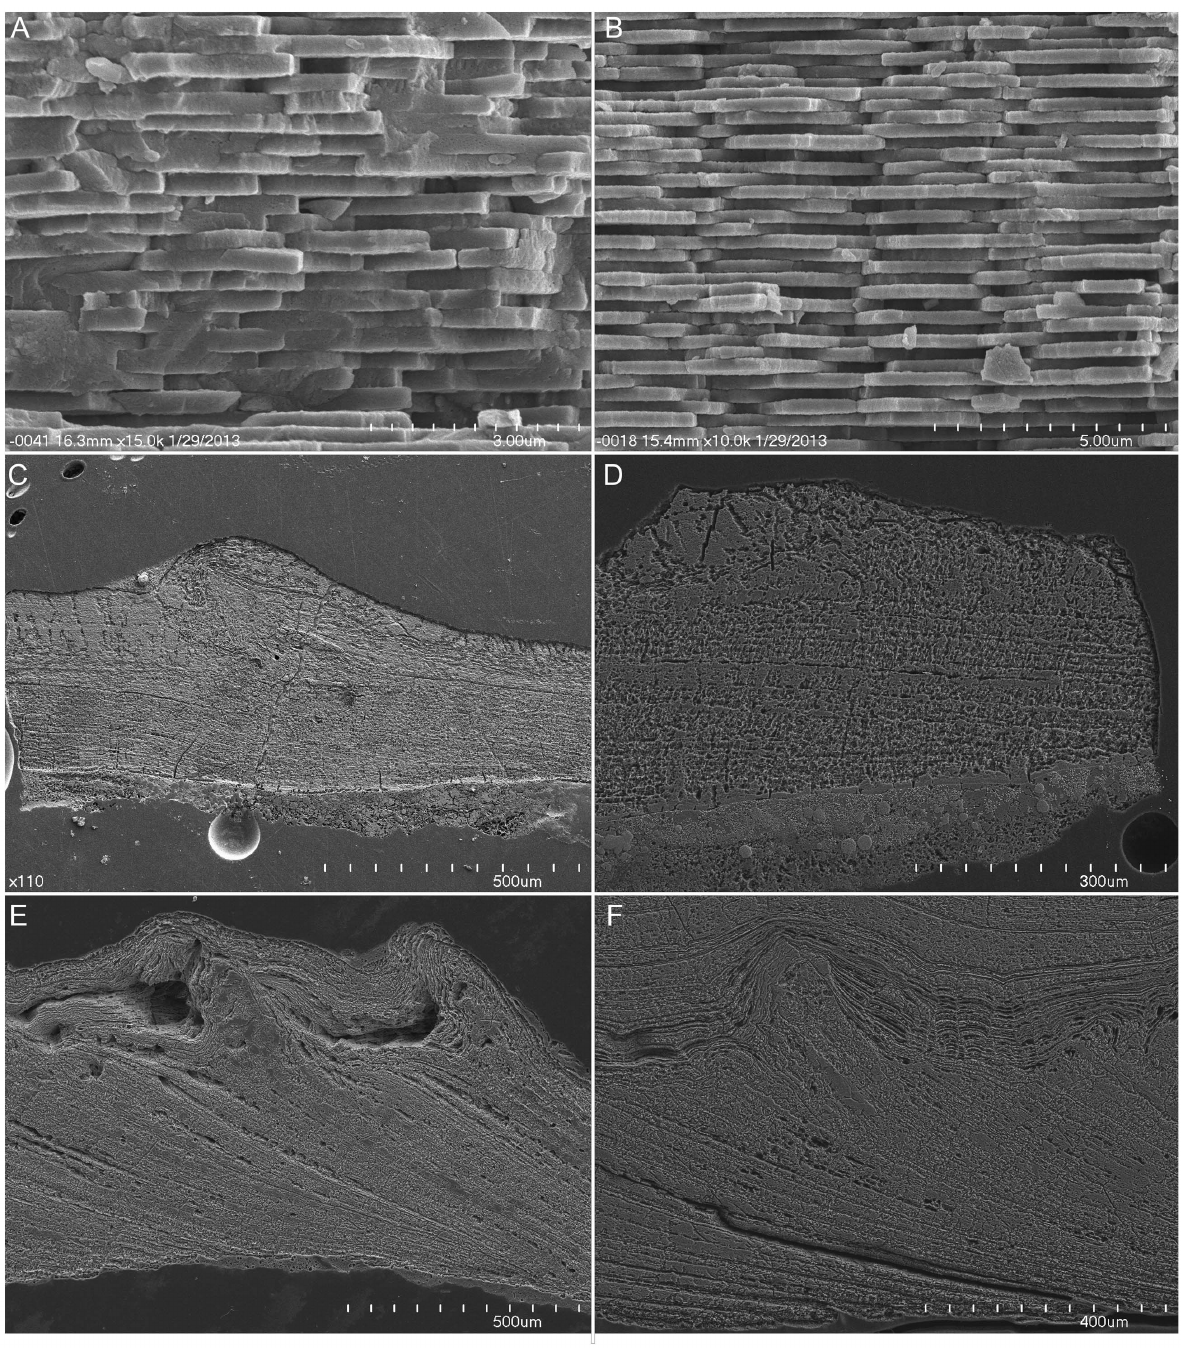
Figure 4. SEM micrographs of the shell and aptychi used to evaluate the Preservation Index. A–B) Nacreous shell in BHI 5146 (A) and AMNH 78053 (B). C–D) Preservation of the aptychi in situ in BHI 5146, and close up (D) showing the calcitic increments. E–F) Preservation in the aptychi from the Mooreville Chalk, showing the differentiated layers (R1 and R2) and the calcitic increments in AMNH 66354 (F) and AMNH 66357 (F). doi:10.1371/journal.pone.0087479.g004 system. The outer shell is secreted by the mantle whereas the jaws Isotopic values of Baculites sp. (smooth) are secreted by tissue in the buccal mass. Therefore, different The isotopic values in the fossil material reflect the quality of sources of carbon (DIC and possibly diet) could be incorporated preservation of the samples. In Baculites sp. (smooth) from the during secretion. Pierre Shale of South Dakota, samples of well-preserved outer shell (PI . 3; table 2 ) yield a mean temperature of 27.5 6 1.4 u C. The sample with the best preserved outer shell and aptychus is BHI 5146. In this specimen, the calculated temperature of the